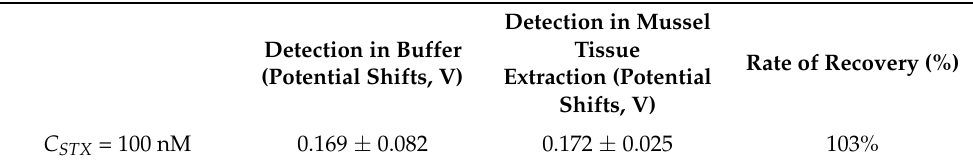
Table 2. The rate recovery detection of 100 nM STX in mussel tissue